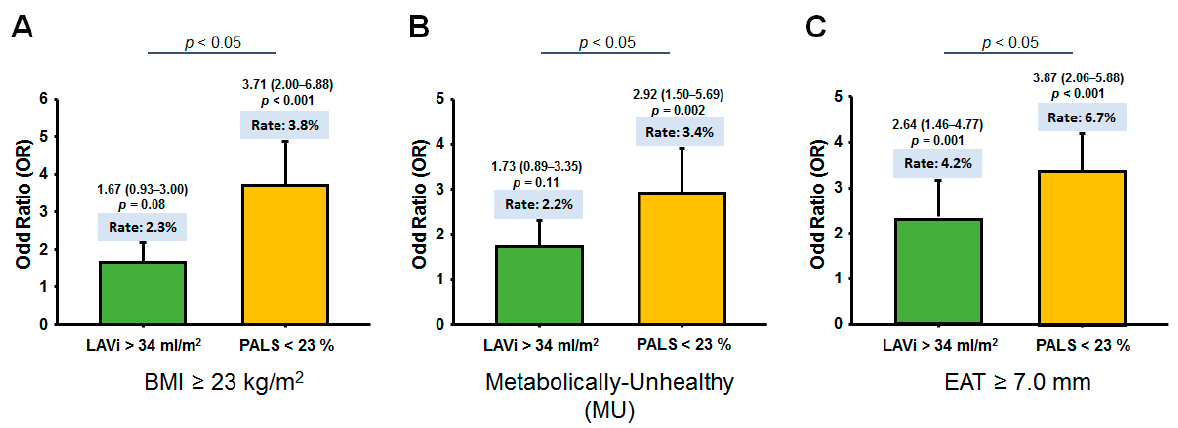
Figure 4. Comparisons of rates of abnormal left atrial volume index (LAVi) (>34 mL/m 2 ) and abnormal left atrium (LA) strain (<23%) by various adiposity measures, defined by body mass index (BMI) strata ( A ), presence of any metabolically unhealthy (MU) condition ( B ), and excessive epicardial adiposity thickness (EAT) ( ≥ 7.0mm) ( C ).